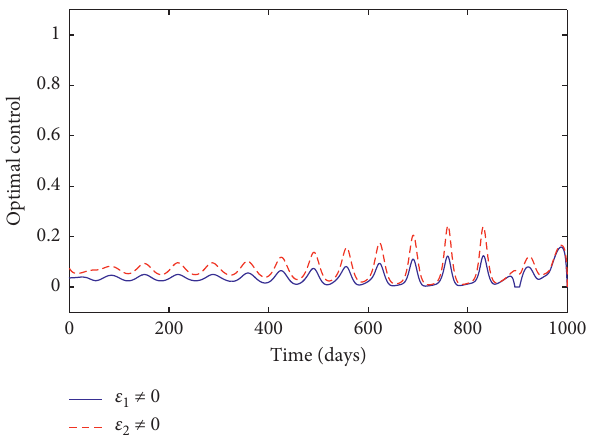
Figure 8: Optimal control strategy with ε